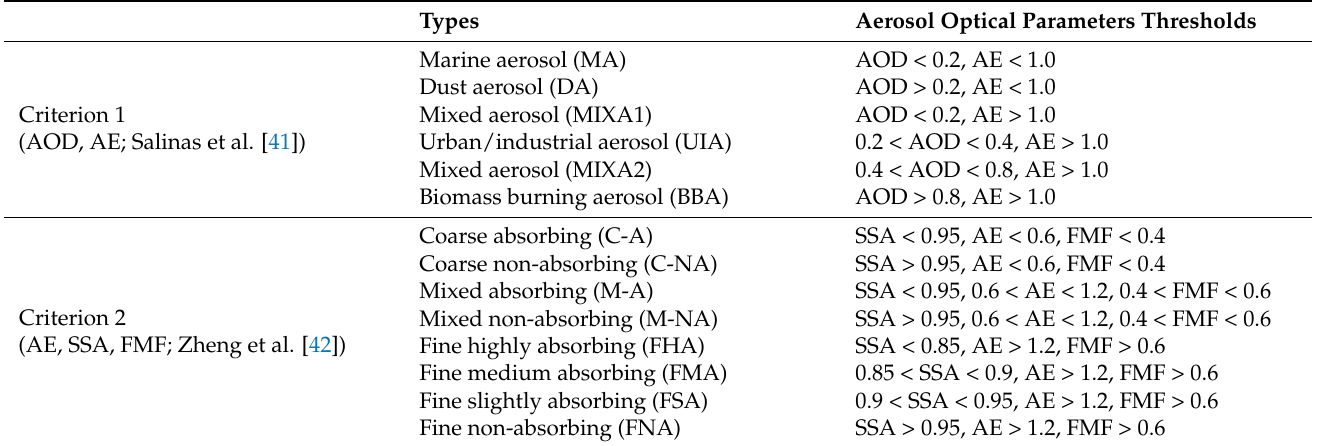
Table 1. Classification criteria based on aerosol optical parameters. Aerosol Optical Parameters